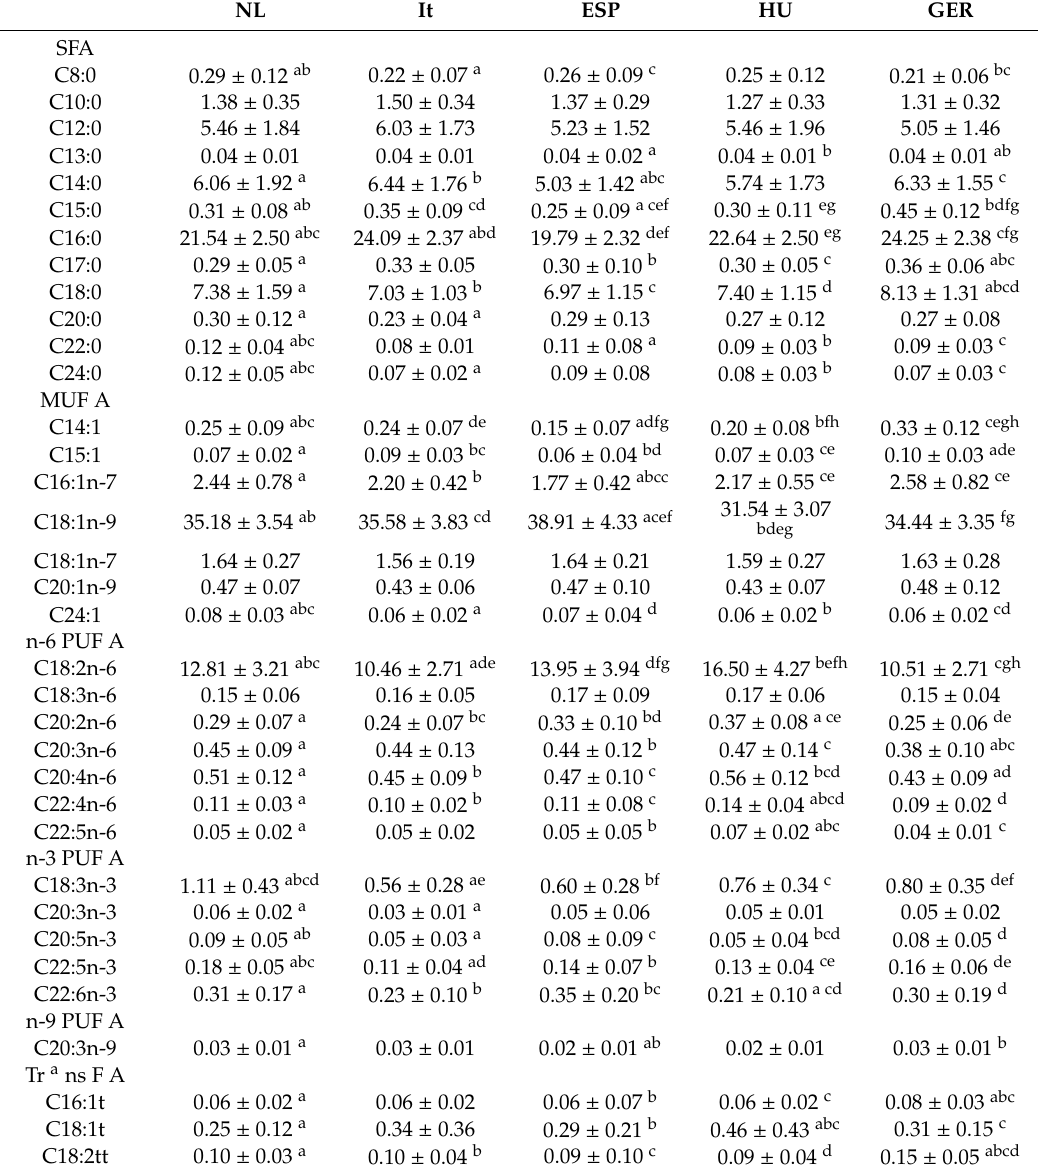
Table 4. Human milk fatty acid composition found in the early samples according to the country of residence of the